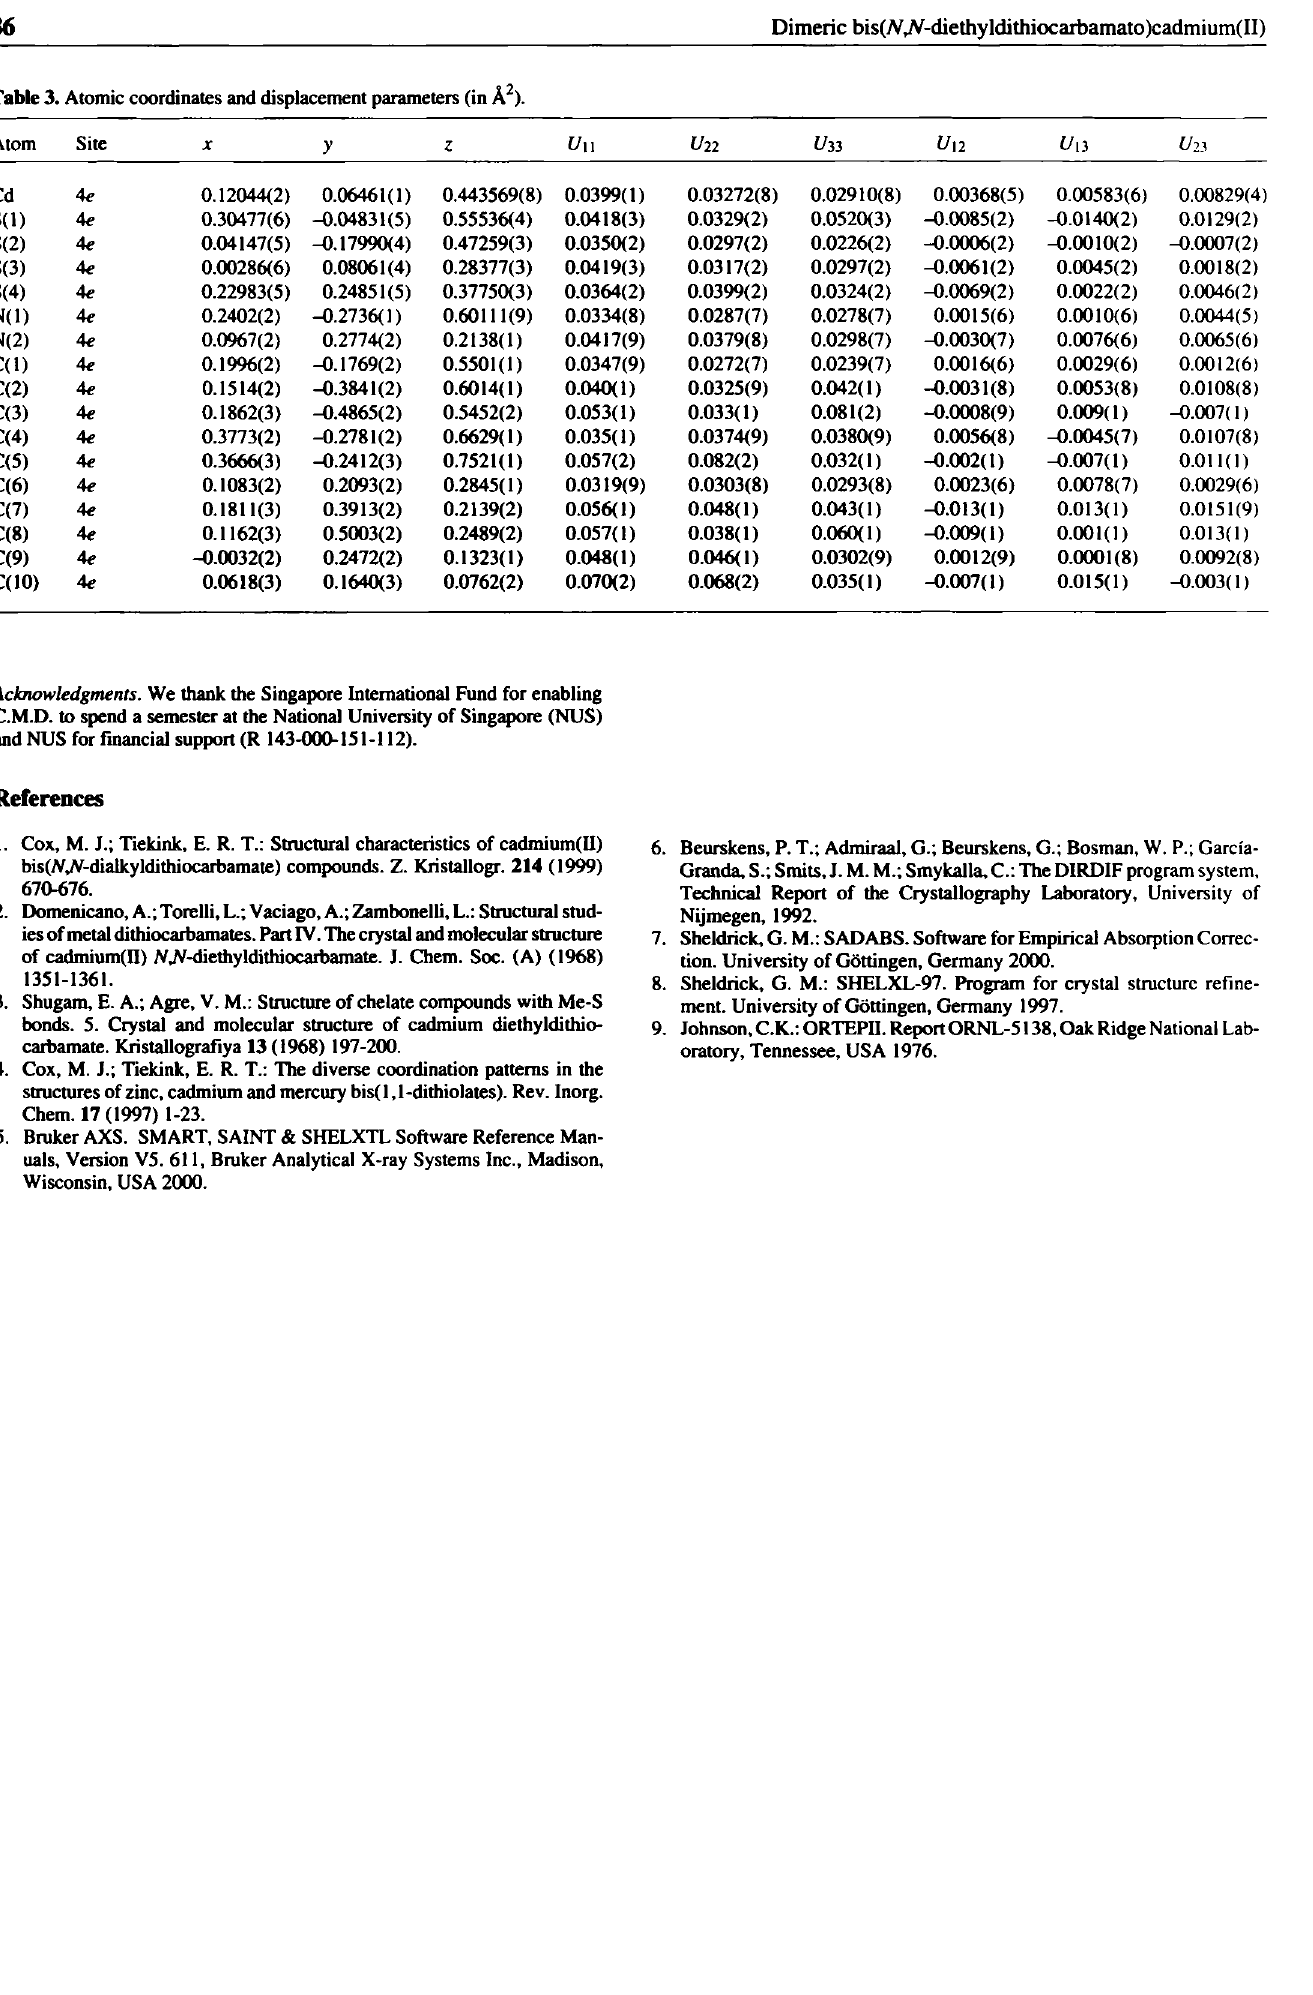
Table 3. Atomic coordinates and displacement parameters (in Â 2